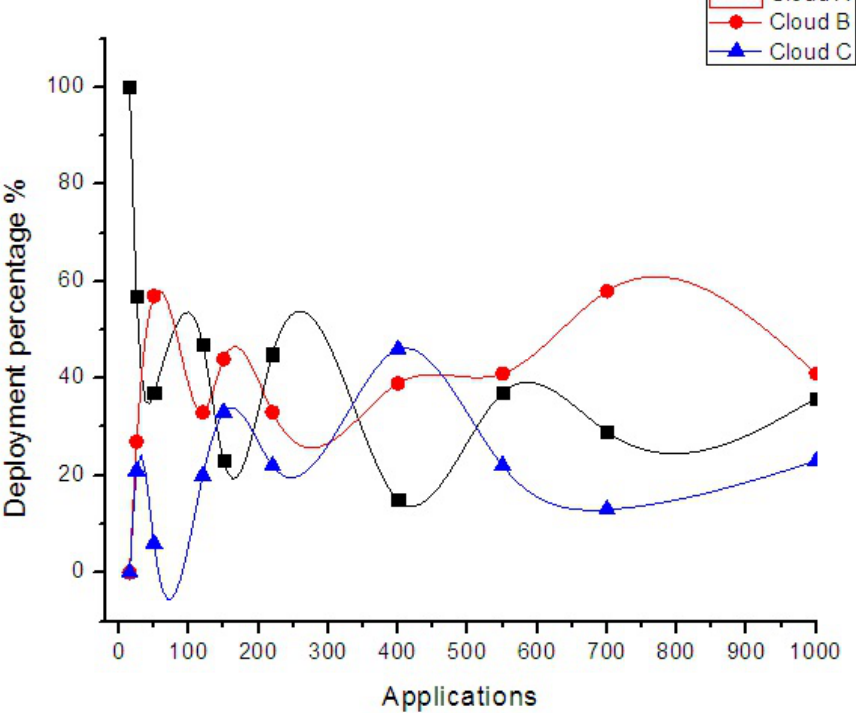
Figure 10. Deployment rate of user